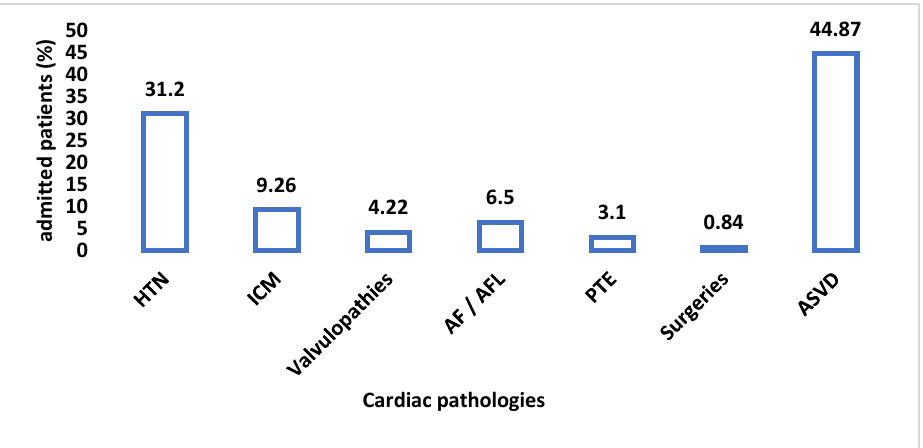
Figure 7. The prevalence of cardiac pathology in patients with SARS-CoV-2 infection. HTN—arterial hypertension, ICM—ischemic cardiomyopathy, Afib—atrial fibrillation, AFL—atrial flutter, PTE—pulmonary thromboembolism, ASVD—arteriosclerotic vascular disease.